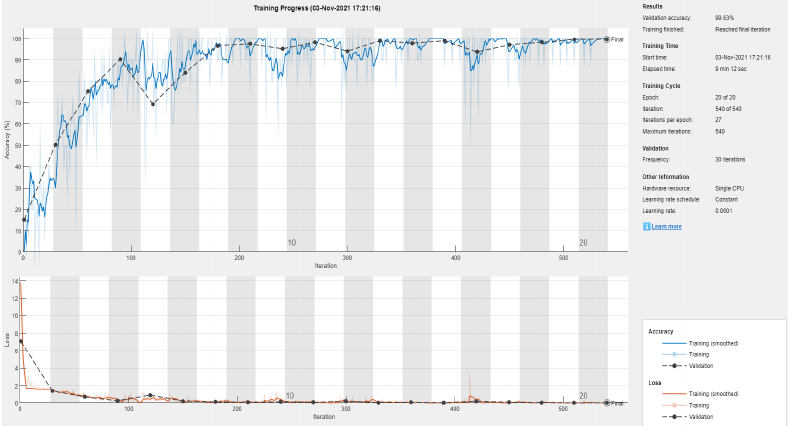
Figure 14. Figure showing training of SqueezeNet using Transfer learning on the Color recurrence plots combining the classes into a single classification problem.